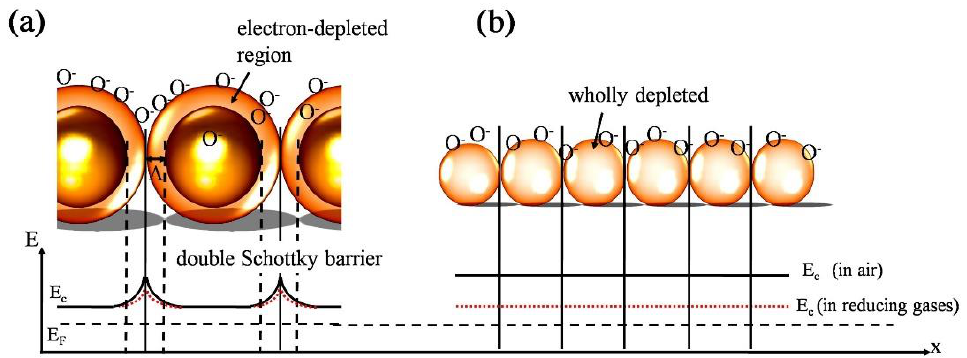
Figure 4. The sensing mechanism of SnO 2 NPs and SnO 2 QDs. ( a ) when the particle size is larger than space-charge layer of SnO 2 ( b ) When the particle size is smaller than space-charge layer of SnO 2 . Reprinted with permission from Ref. [27]. Copyright 2016,